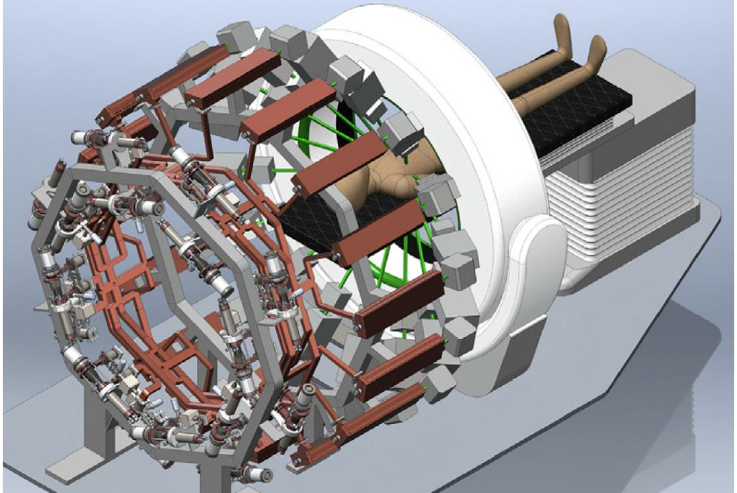
Figure 15. Conceptual diagram of the PHASER architecture with 16 linacs arrayed around the patient for highly conformal FLASH photon therapy. Reproduced with permission from Ref. [142].